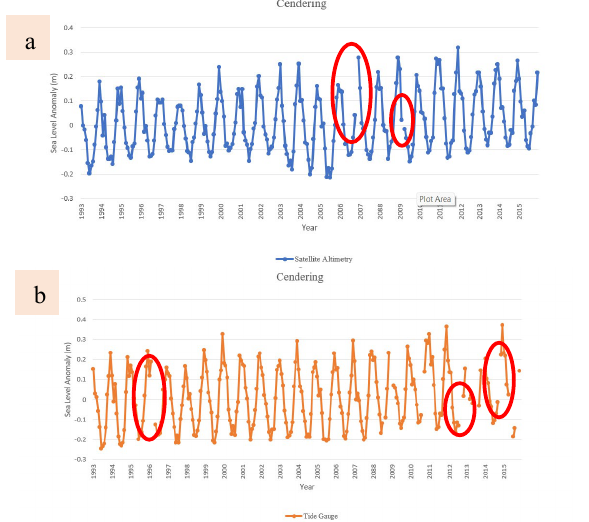
Figure 4. Graph of sea level anomaly pattern from (a) satellite altimetry and (b) tide gauge. Red circles show the data gap According to Hyndman and Koehler (2006), by computing the RMSE value, the standard deviation of the residual can be determined to identify the error value, while the R-value demonstrates the constancy of the datasets pattern (Glantz et al., 1990; Hamden et al., 2021). In this study, the R-value is data. The R-value calculated for these two datasets is 0.903,